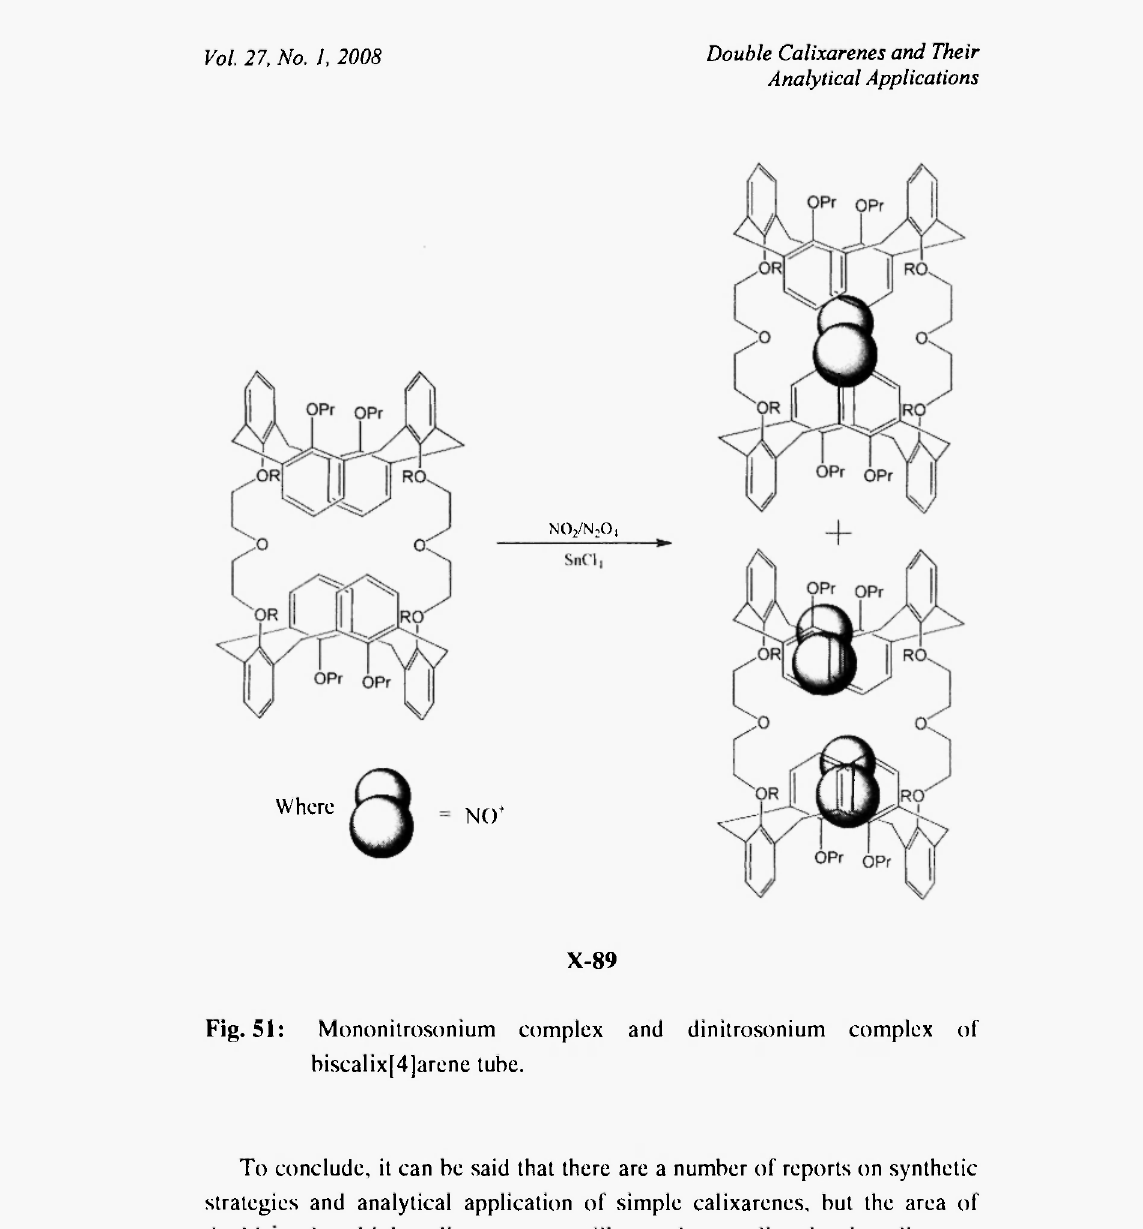
Fig. 51: Mononitrosonium complex and dinitrosonium complex of biscalix[4]arene